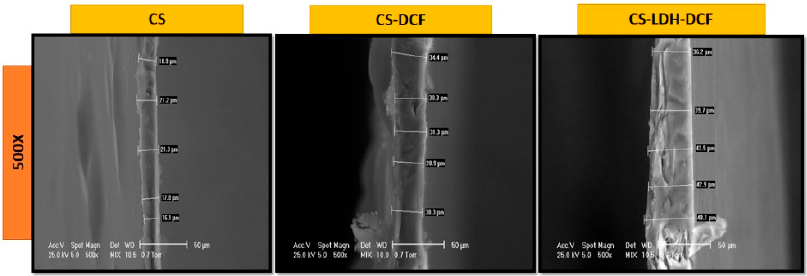
Figure 3. SEM images of the cross-section view of chitosan, chitosan loaded with diclofenac, and chitosan–LDH loaded with diclofenac. chitosan–LDH loaded with